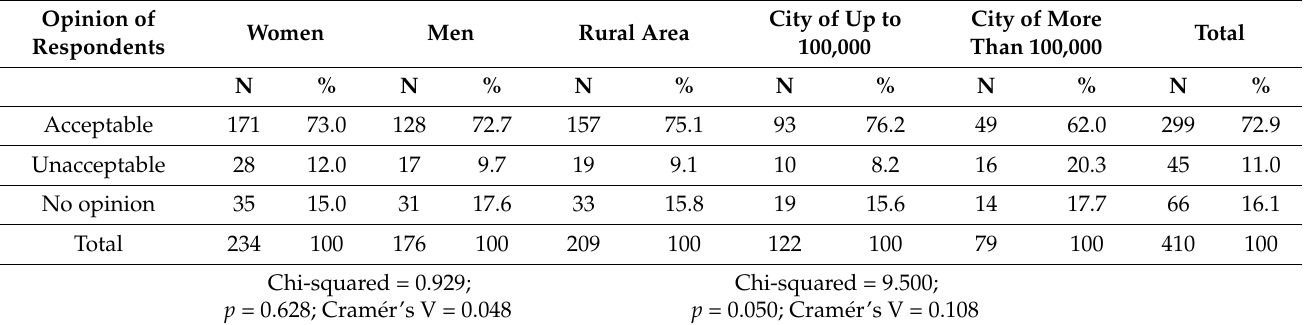
Table 2. Opinions on the acceptability of sexual intercourse before